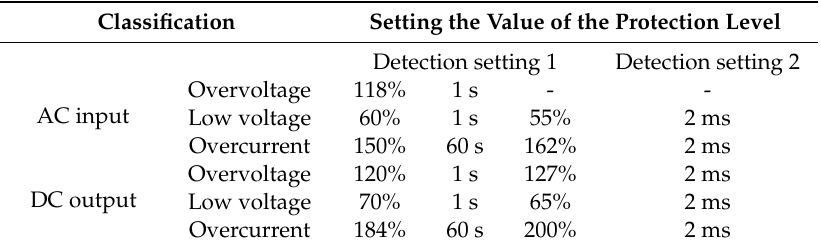
Table 3. Protection level at the input / output of the AC / DC power converter.